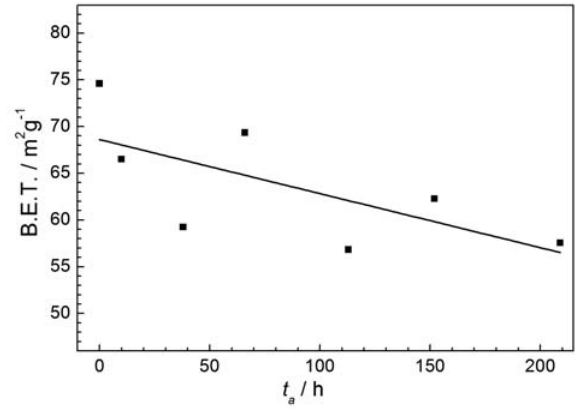
Figure 5. The specific Brunauer–Emmett–Teller (BET) surface area of the samples aged for 0, 10, 38, 66, 113, 159, and 209